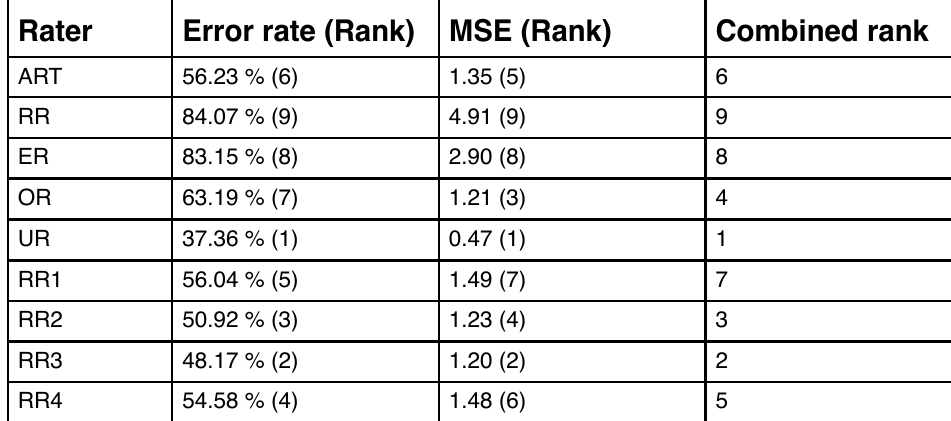
Raters’ performance: Error rate, MSE, and combined rank Rater Error rate (Rank) MSE (Rank) Combined